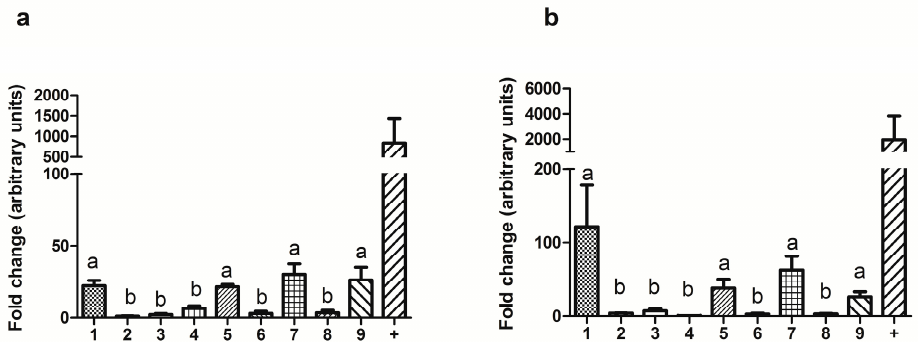
Figure 1. Real-time polymerase chain reaction (qPCR) analysis of ( a ) MT 1 and ( b ) MT 2 melatonin receptors from mRNA obtained from various tissues of the ram reproductive tract: Testis (1), caput (2), corpus (3) and cauda epididymis (4), ampulla (5), prostate (6), seminal vesicles (7), bulbourethral glands (8), and ductus deferens (9) . Ovine granulosa cells and ovine retina were used as positive control (+) for ( a ) MT 1 and ( b ) MT 2 , respectively. Values of mRNA relative expression are shown as mean ± SEM of two males analyzed twice ( n = 4). Each qPCR run was performed in triplicate. Glyceraldehyde-3-phosphate dehydrogenase ( GAPDH ) and β -actine genes were used as housekeeping genes. Different letters a, b mean statistical differences of p < 0.05 (positive controls were only used for representative purposes, and were not included in the statistical analyses).